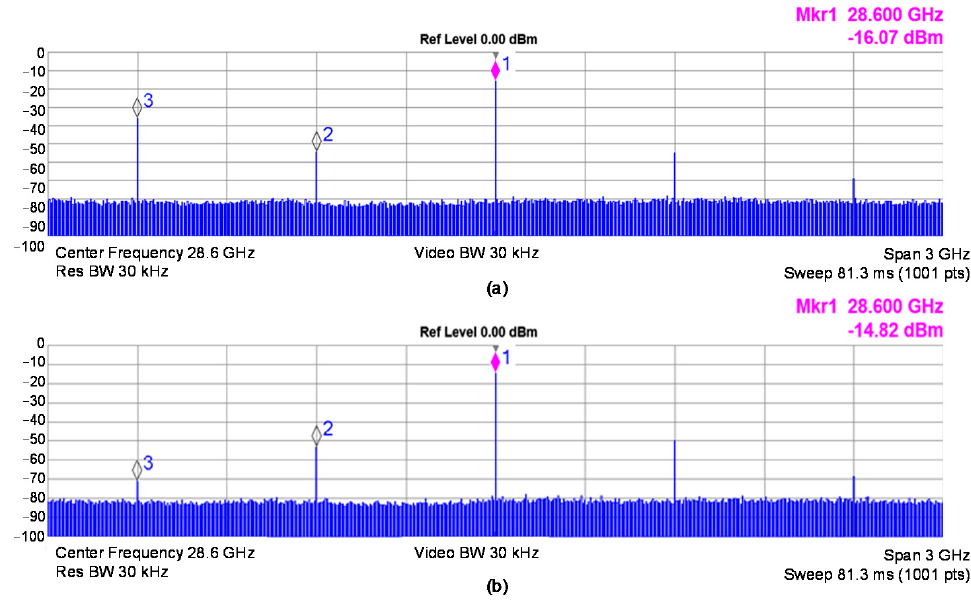
Figure 12. Measured output spectrum ( a ) before calibration and ( b ) after calibration.